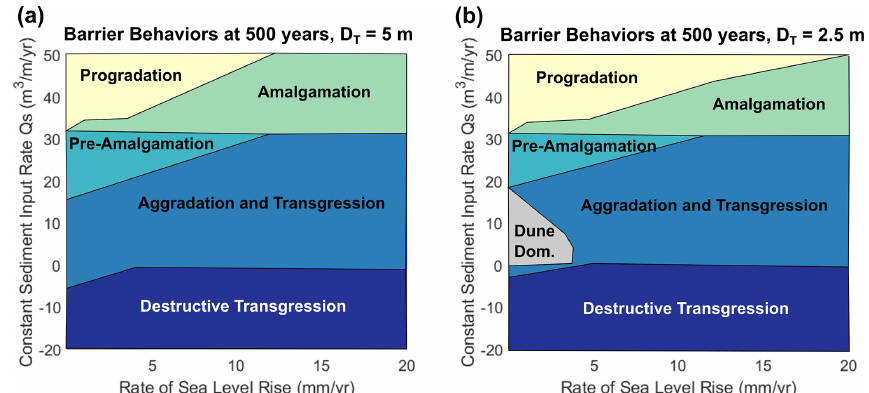
Figure 9. Behavior of the modeled barrier in response to combinations of Q S and SLR over 500 years for (a) D T = 5m and (b) D T = 2 . 5m. A region of D T = 2 . 5m where SLR is less than 5mmyr − 1 and Q S is between 0 and 20m 3 m − 1 yr − 1 is subject to “dune dominance”, where the barrier volume is preferentially stored in the subaerial domain. D T is the thickness of the barrier substructure or the depth of the active shoreface over decadal timescales. Q S represents shoreface